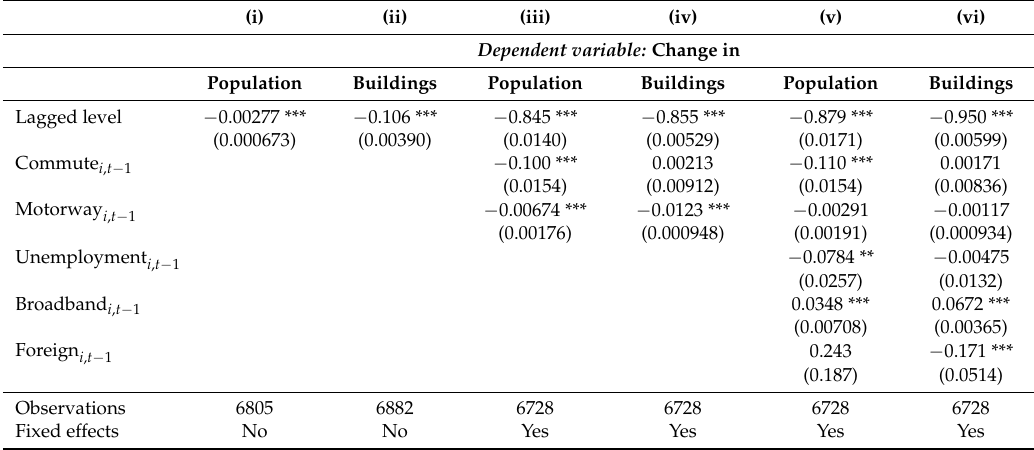
Table 6. Testing for